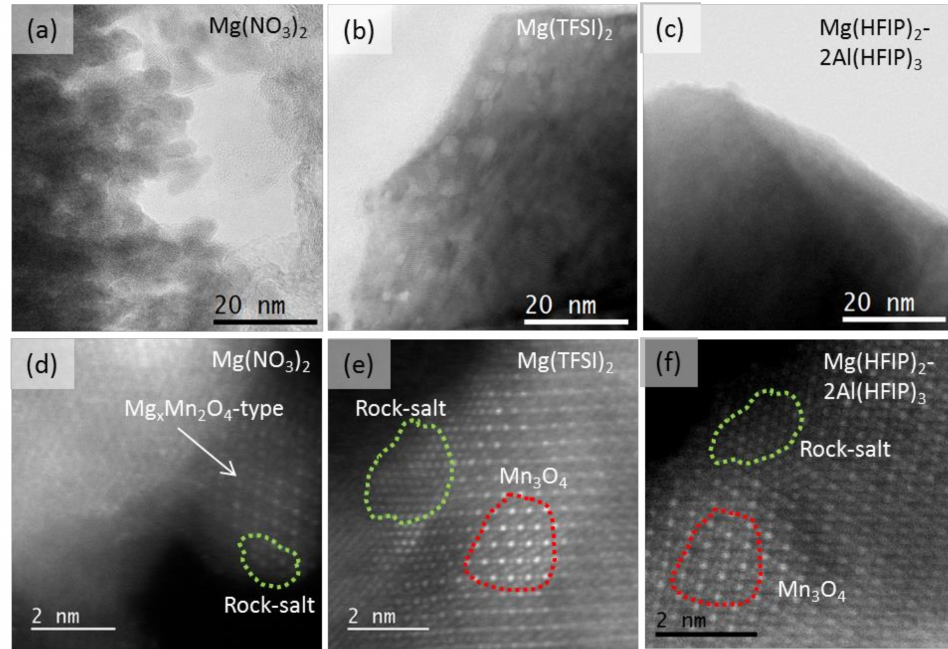
Figure 5. STEM-BF and atomic resolution STEM-HAADF images of magnesiated spinel cathodes cycled in: ( a , d ) Mg(NO 3 ) 2 for 100 cycles; ( b , e ) Mg(TFSI) 2 /diglyme for 15 cycles; ( c , f ) Mg(HFIP) 2 − 2Al(HFIP) 3 /diglyme for 60